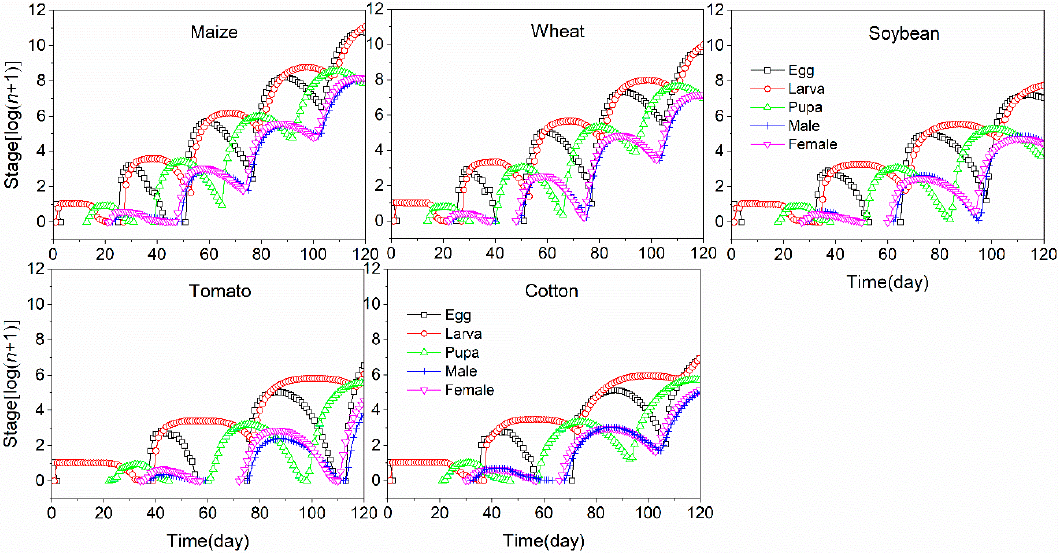
Figure 6. Projection of population growth potential of S. frugiperda fed on five host crops for duration of 120 days.